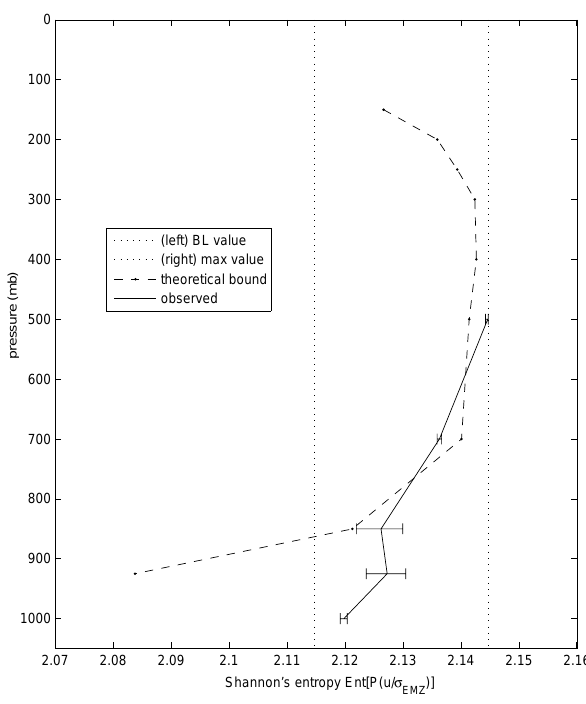
Fig. 10. Figure 10 shows Shannon’s entropy at 500mb and below for the Weibull’s distributions fitted to the non-dimensional wind speed u = v/σ from Equatorial Monsoon Zone (solid line). u was first normalized by its rms value σ EMZ as the latter is close to but not exactly 1. The maximal entropy and the value associated with k = 5 / 3 (dotted lines) are shown, as well as the theoretical bound (dashed line) for reduction from maximal